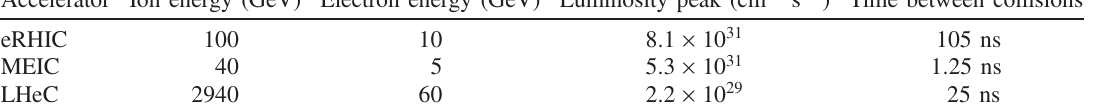
TABLE I. Parameters for different proposed electron-ion colliders with heavy ion beams. eRHIC will use gold beams, while the MEIC and LHeC will accelerate lead beams. The ion energy is per nucleon, while the luminosity is the eA luminosity, rather than the e -nucleon luminosity. For MEIC, the value for a high-luminosity interaction region is used